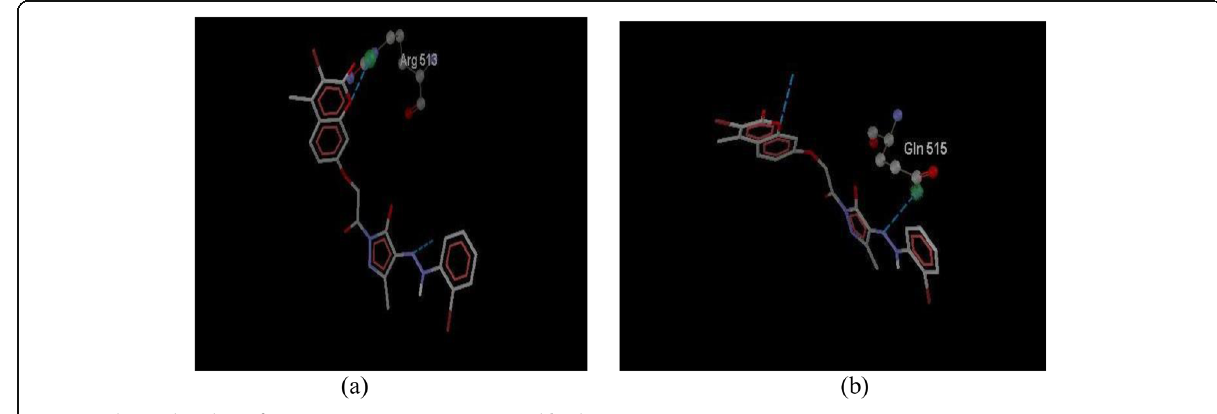
Fig. 2 Hydrogen bonding of D1 at a Arginine 513 position and b Glutamine 515